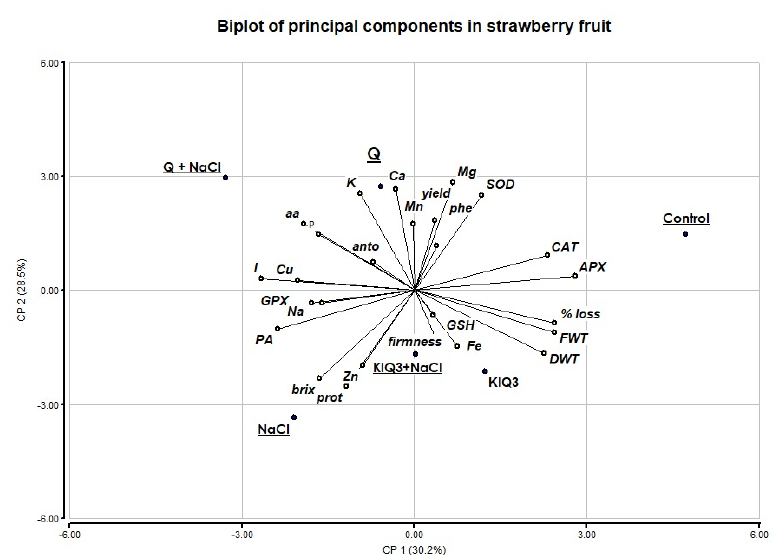
Figure 3. Biplot of parameters of antioxidants, elements, quality, growth and yield in strawberry fruit, under both conditions.